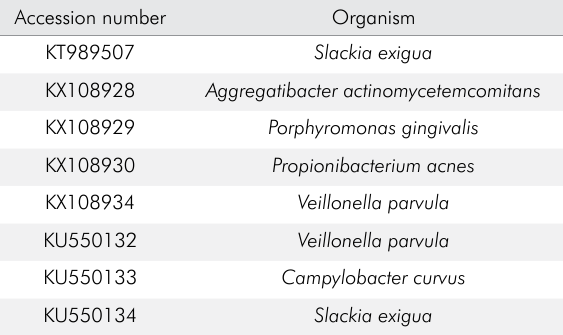
Table 1. Accession numbers of obligatory anaerobic bacteria registered in the GenBank database (http://www.ncbi.nlm.nih. gov/guide/dna-rna/).